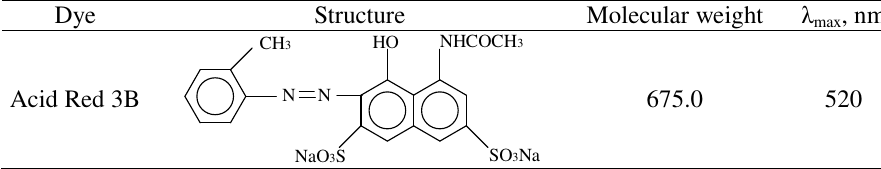
Table 2. Chemical structure and molecular weight of Acid